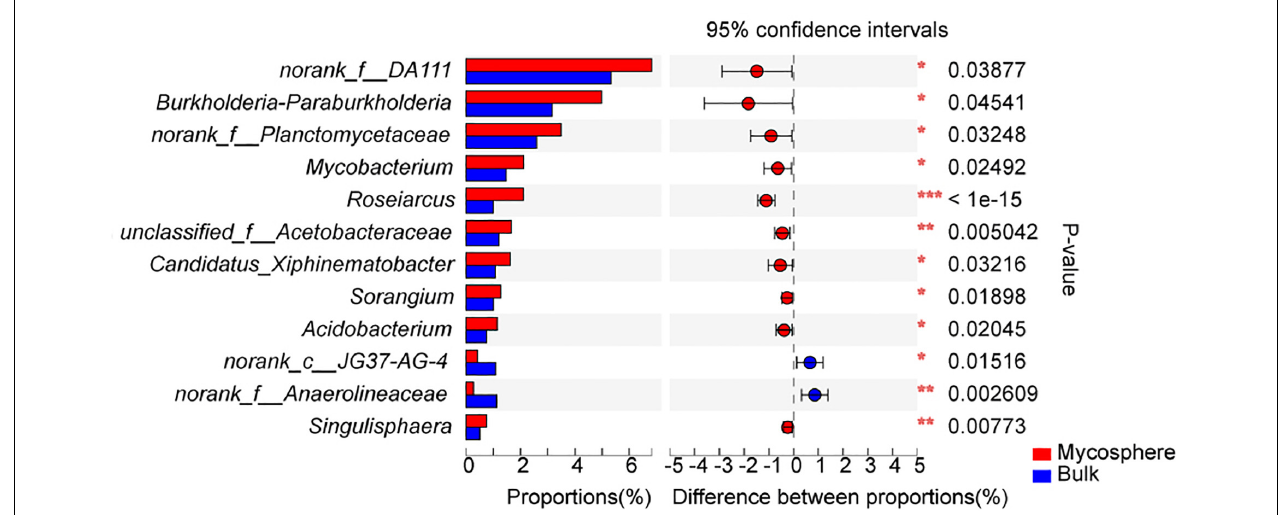
FIGURE 4 | Significant differences among the top 30 genera between mycosphere and bulk soil. Significant differences by * p < 0.05; ** p < 0.01 and *** p < 0.001.